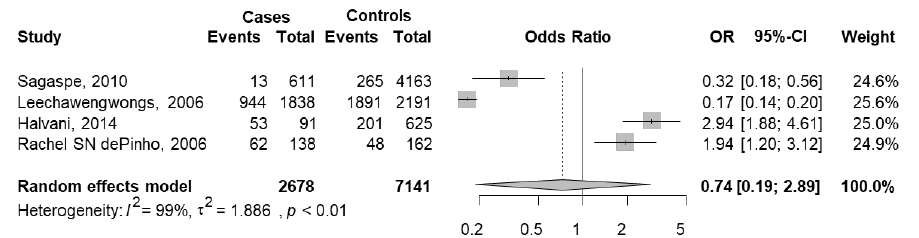
Figure 7. The forest plot of the meta-analysis of ESS ≥ 10 and car crashes [27,31,37,58]. Events Cases are defined as car crashes with ESS ≥ 10 (total of 1062) and Total Cases as subjects with ESS ≥ 10 (2678); Events Controls are defined as car crashes without ESS ≥ 10 (total 2405) and Total Controls as subjects without ESS ≥ 10 (7141). The whiskers represent the 95% confidence interval (CI). The diamond represents the pooled OR estimate based on the random effects model, with the center representing the point estimate and the width the associated 95% CI. I 2 describes the percentage of the variability in effect estimates that is due to heterogeneity rather than sampling error, ranging from 0 (no heterogeneity) to 100 (maximum heterogeneity).